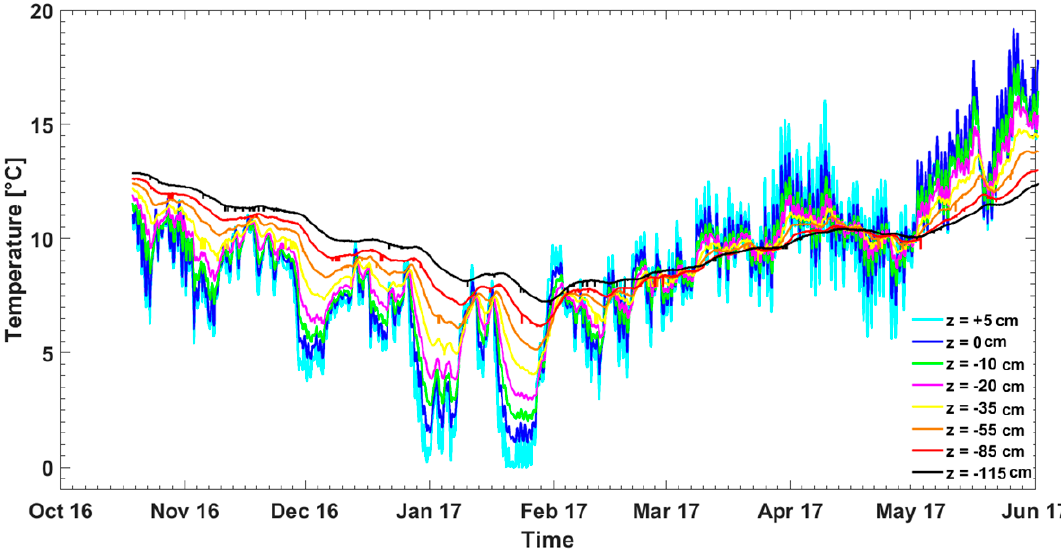
Figure 4. Example of temperature profile dynamics along the hyporheic zone from the thermal lance located in the wetland sub-reach.